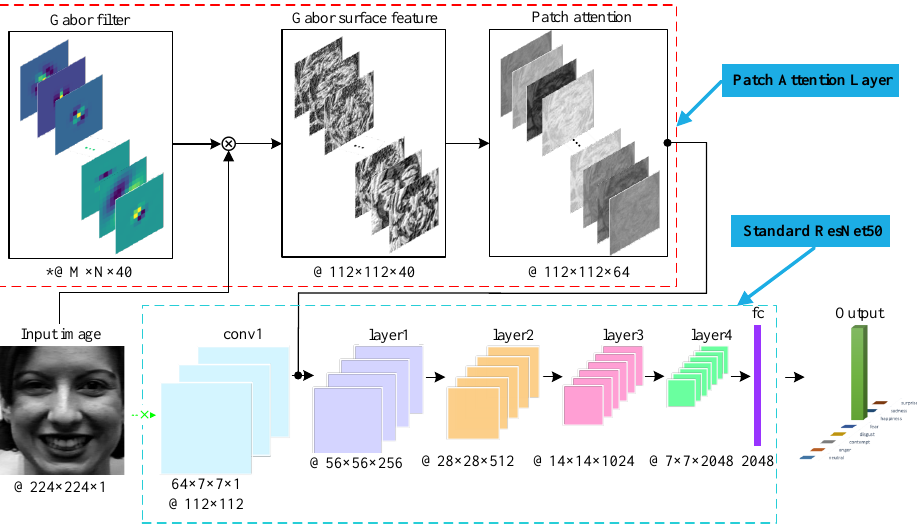
Figure 1. Framework of the proposed Patch Attention Layer (PAL) with the backbone network. “*” denotes that M and N are variable depending on the input Gabor